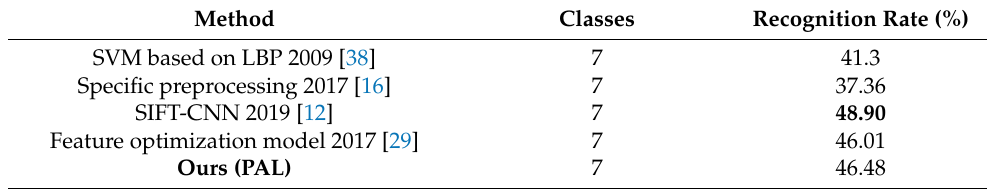
Table 6. Cross-database evaluation on the JAFFE with models trained on the